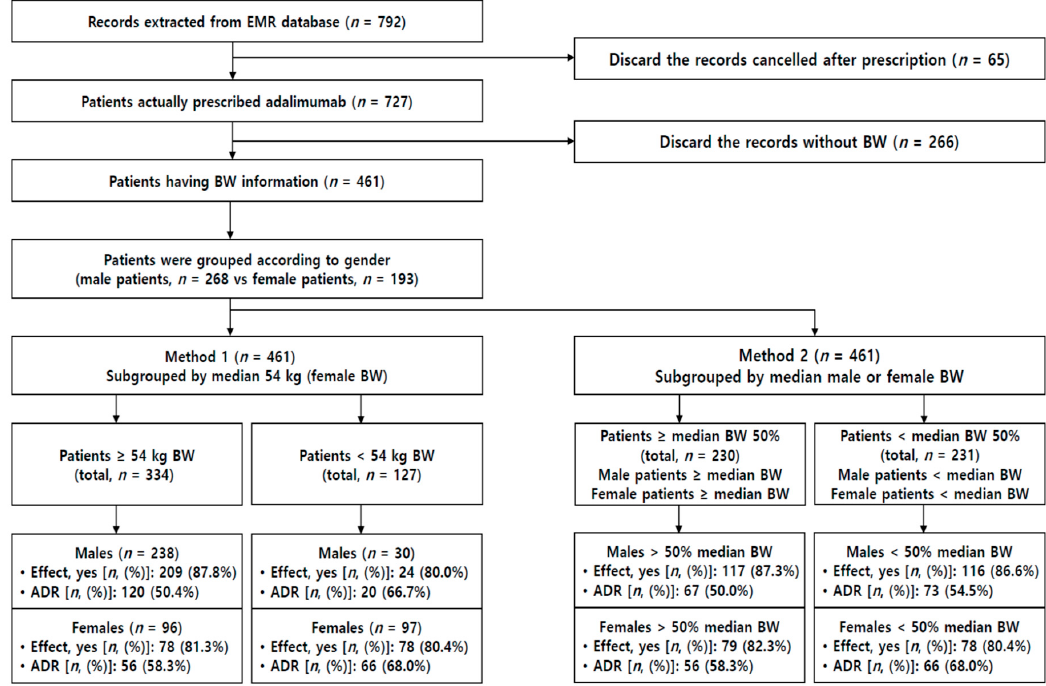
Figure 1. A flowchart showing subgrouping of patients, adverse drug reactions (ADRs), adalimumab in patients with records of body weight (BW). Table 1. The efficacy and adverse drug reactions (ADRs) of adalimumab in patients with records of body weight (BW).